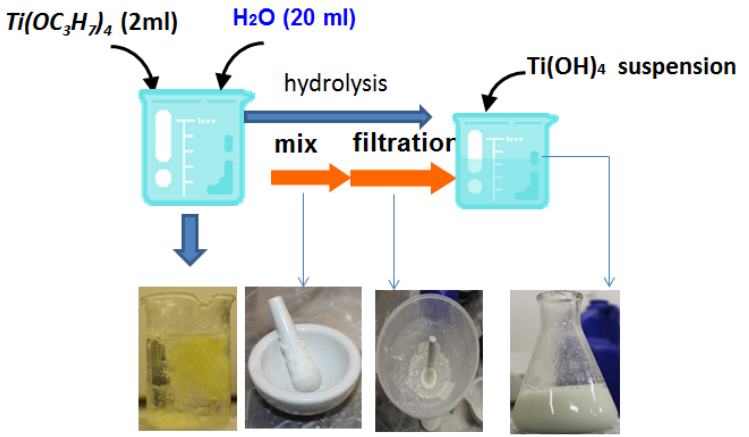
Figure 5. The shape of submicron particles.